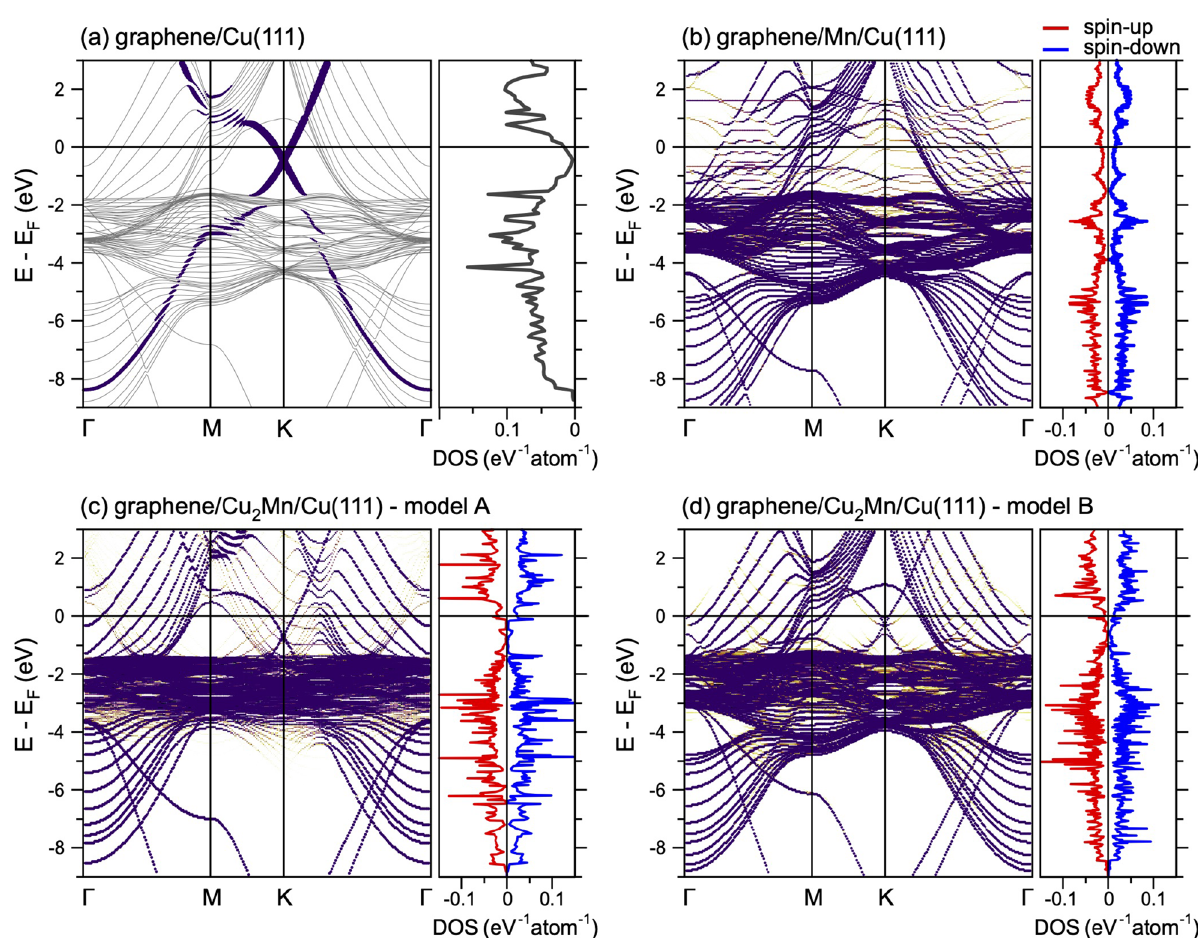
Figure 2. Band structures and C- p z projected density of states calculated for graphene/Cu(111) ( a ), graphene/ Mn/Cu(111) ( b ), graphene/ Cu 2 Mn/Cu(111)—model A ( c ), and graphene/ Cu 2 Mn/Cu(111)—model B ( d ) in their energetically most favourable structures. In ( b – d ) spin-resolved band structures obtained after unfolding 1 ) primitive cell are presented for spin-up channel. The color of the point procedure for the graphene ( 1 × (yellow–orange–violet color scale) gives the information about the number of primitive cell bands crossing particular ( k , E ) in the unfolded procedure, i.e., the partial density of states at ( k , E